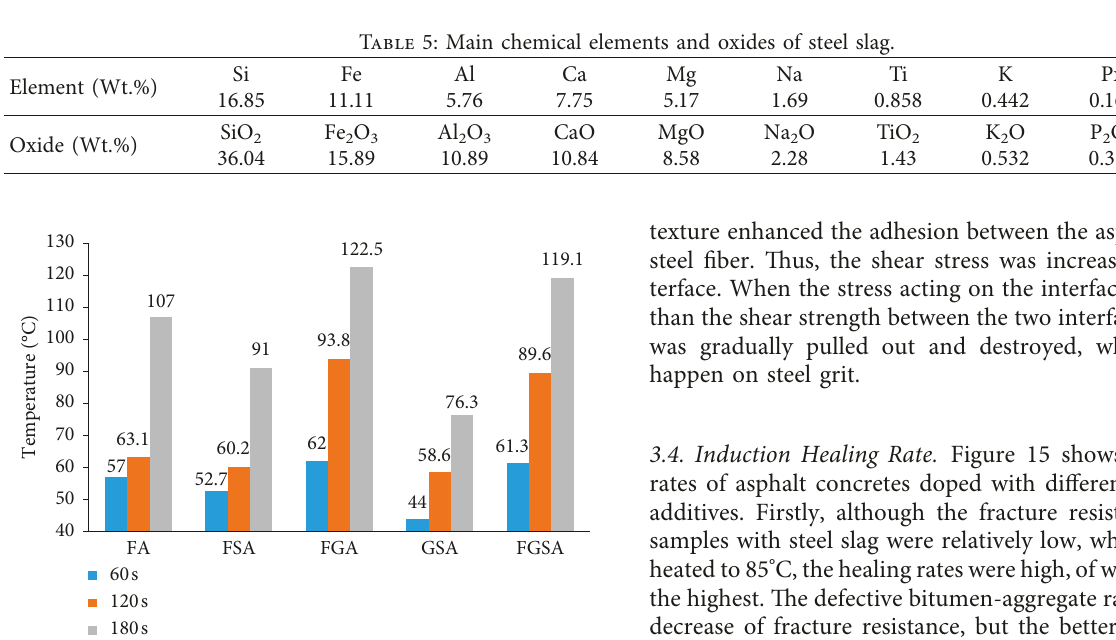
Figure 10: Induction heating temperature of asphalt concretes after different induction heating